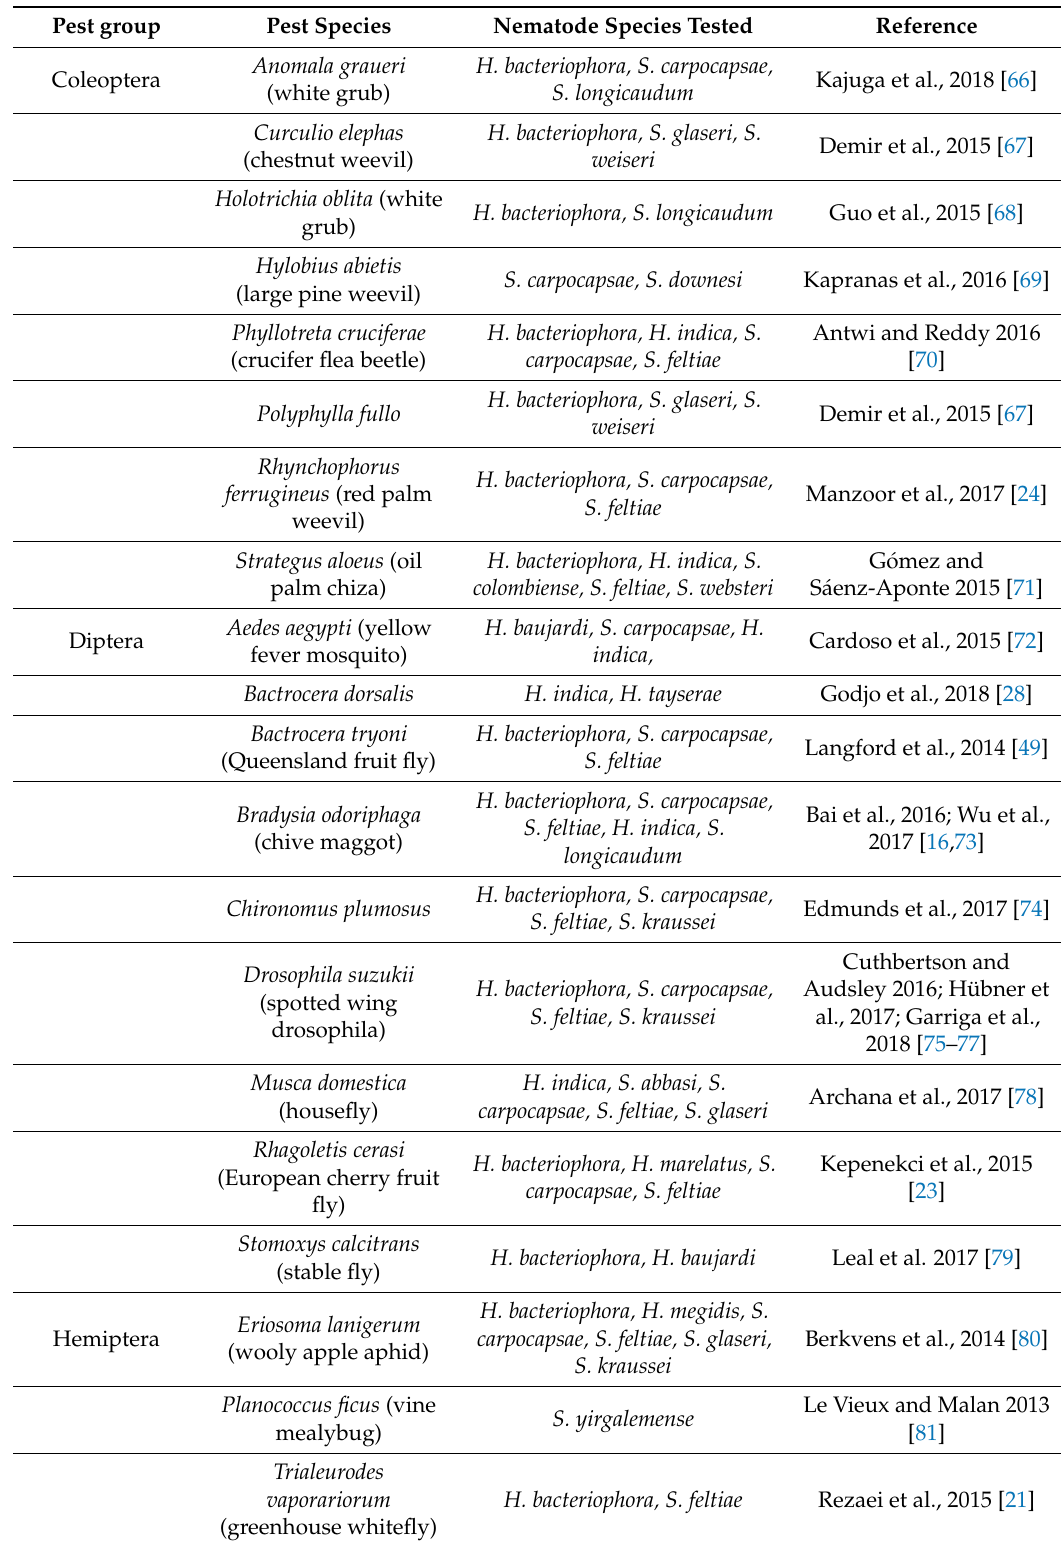
Table 1. Recent studies (2014—present) investigating the effect of entomopathogenic nematodes against insect